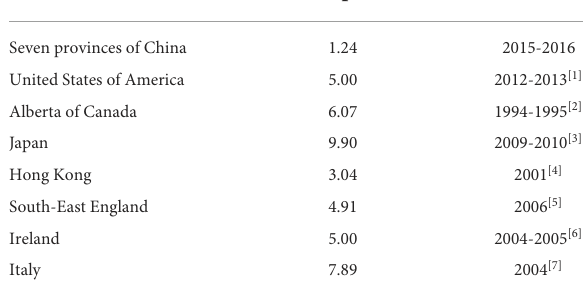
TABLE 5 Epidemiological and clinical characteristics of ALS patients in hospital survey ( n = 169).